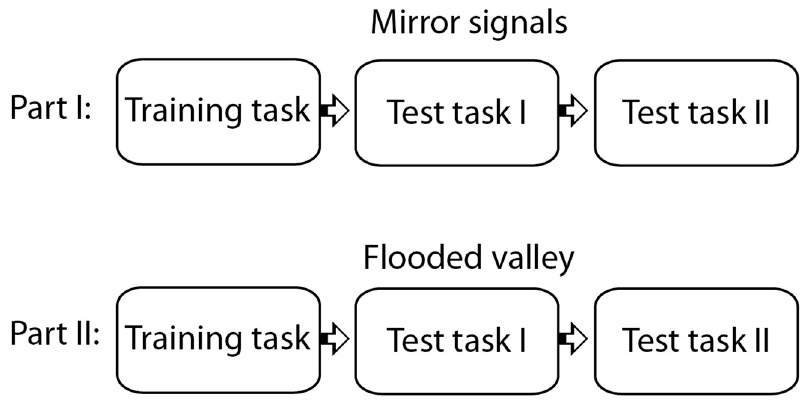
Figure 6. Step 4: collaboration in the CIVE—research tasks administration in detail.